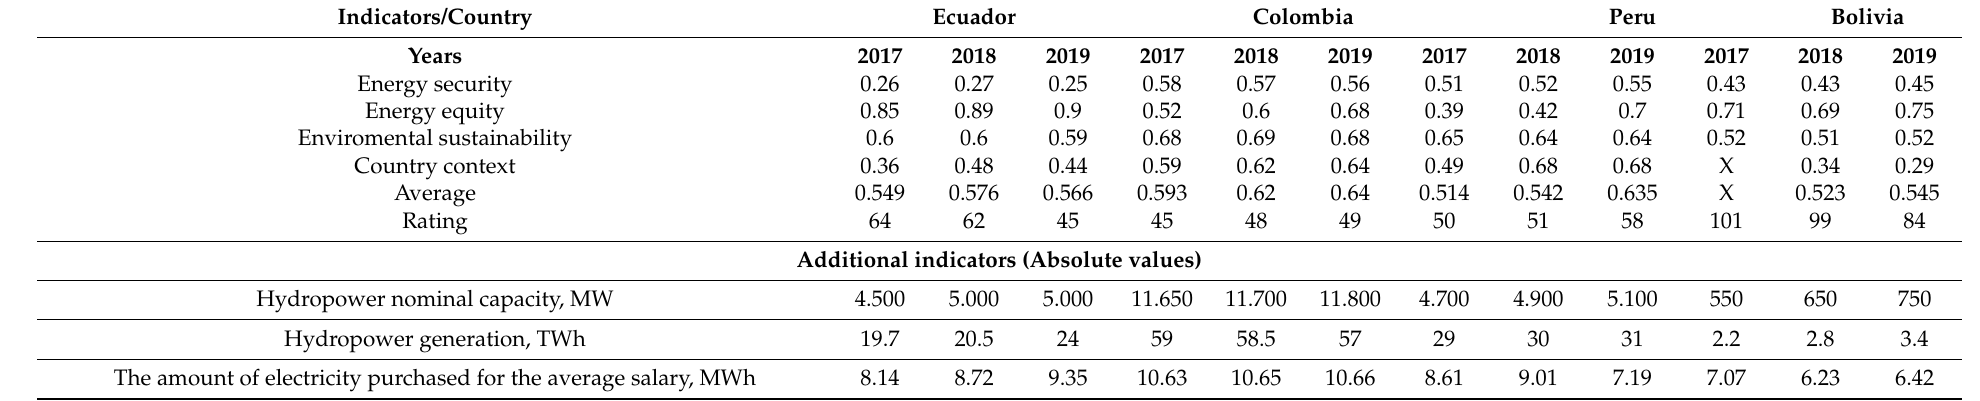
Table 15. Total score for all individual indicators and the average values of the energy sustainability